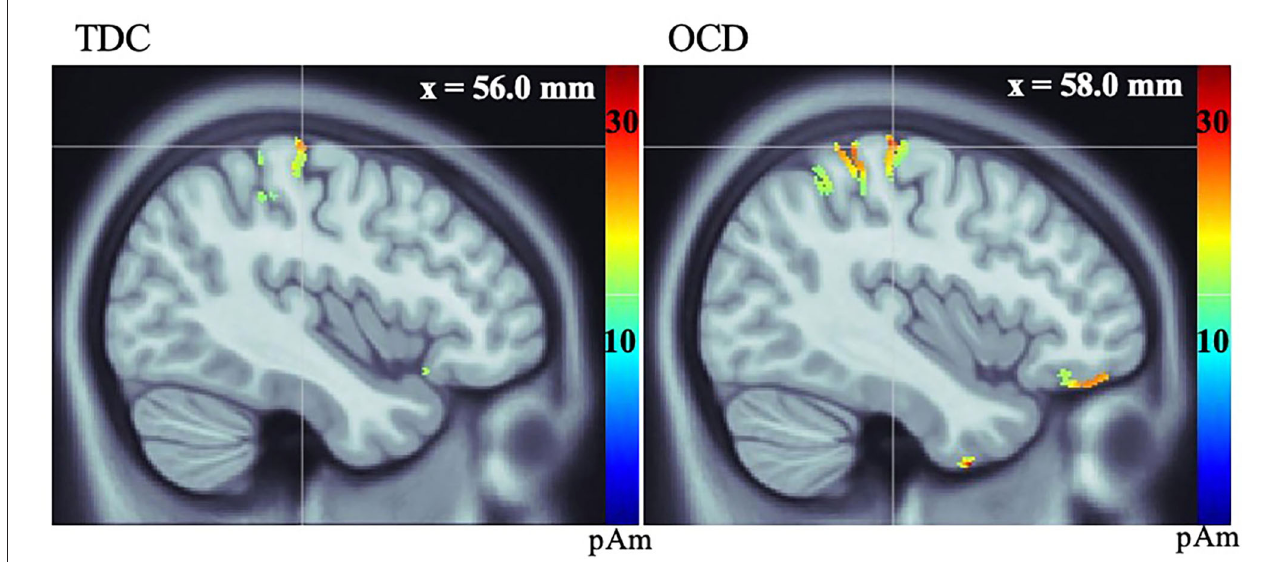
FIGURE 1 | Source localization, measured in picoamperes (pAm), of group average response of primary motor cortex (MI) in TDC (left), and OCD (right) groups during button-press to Go visual cue.